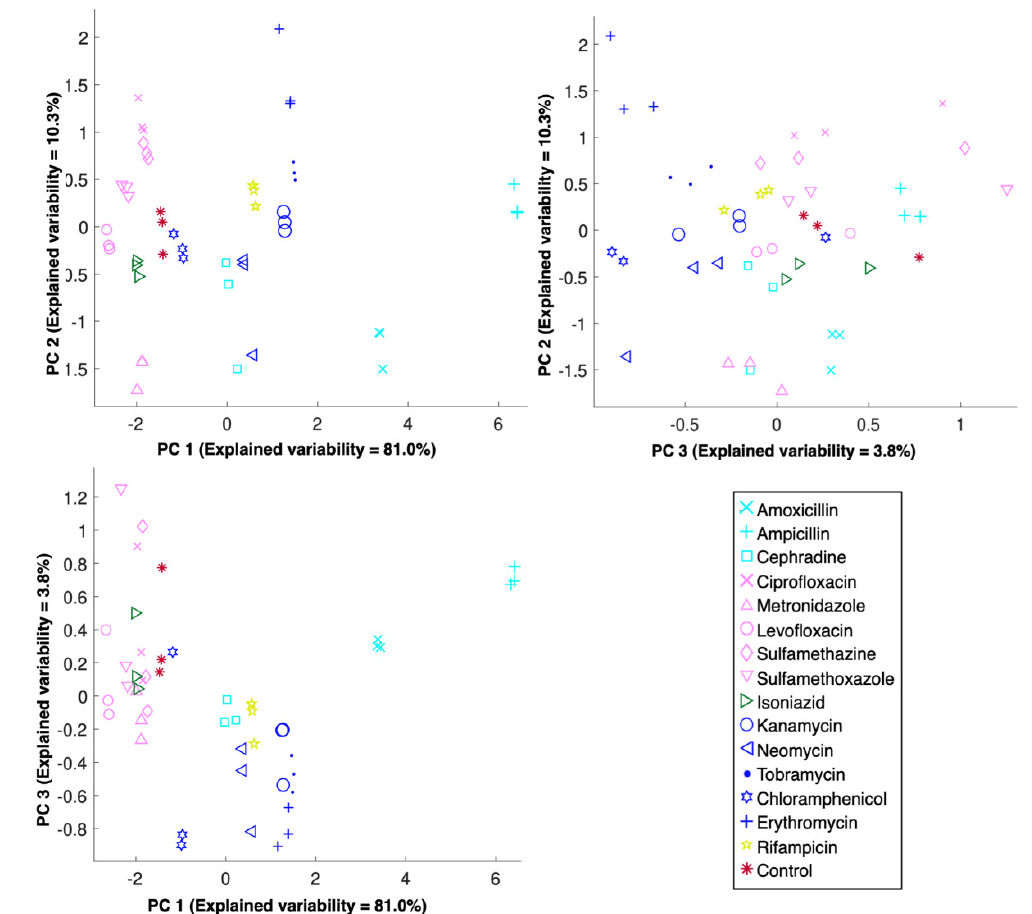
Figure 4. Representation of the metabolic fingerprints induced by 15 antibiotics acting on the major biosynthetic pathways after Principal Component Analysis (PCA), preceded by an optimized combination of preprocessing algorithms. The variability explained by each Principal Component (PC) is reported for each corresponding axis. Antibiotics acting on the same major biosynthesis pathway are represented using the same color, and individual antibiotics are represented with a unique symbol.